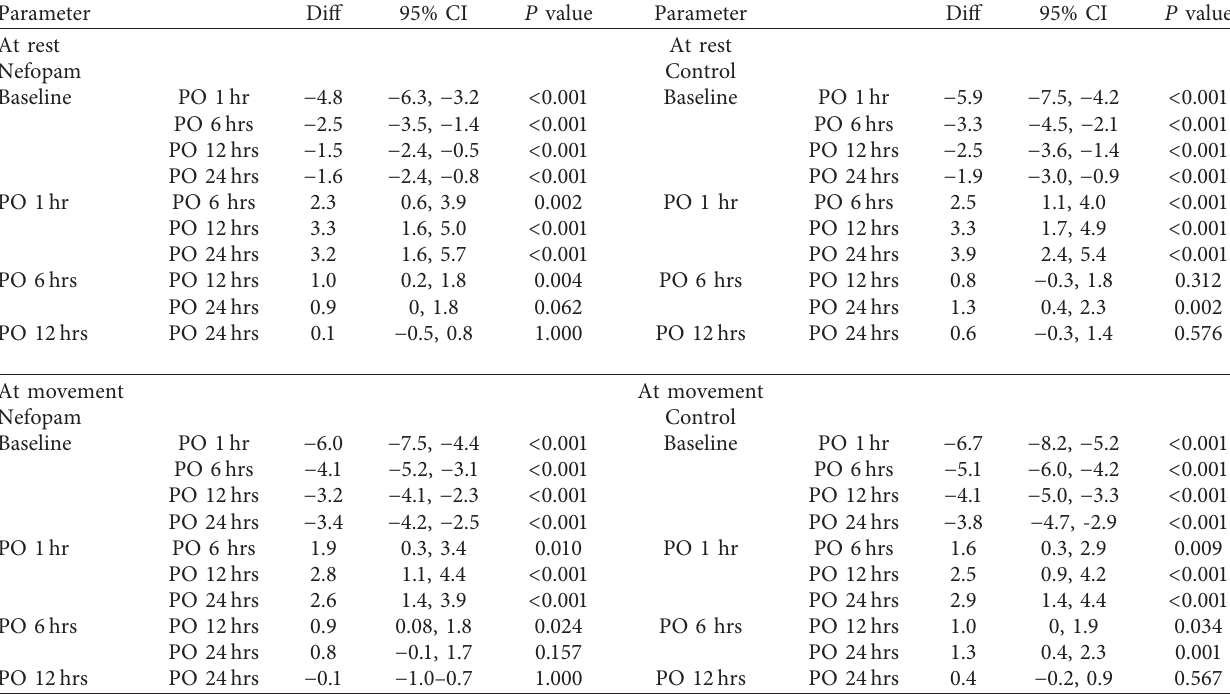
Table 6: Multiple comparison of pain scores during at rest and movement between nefopam and control groups.